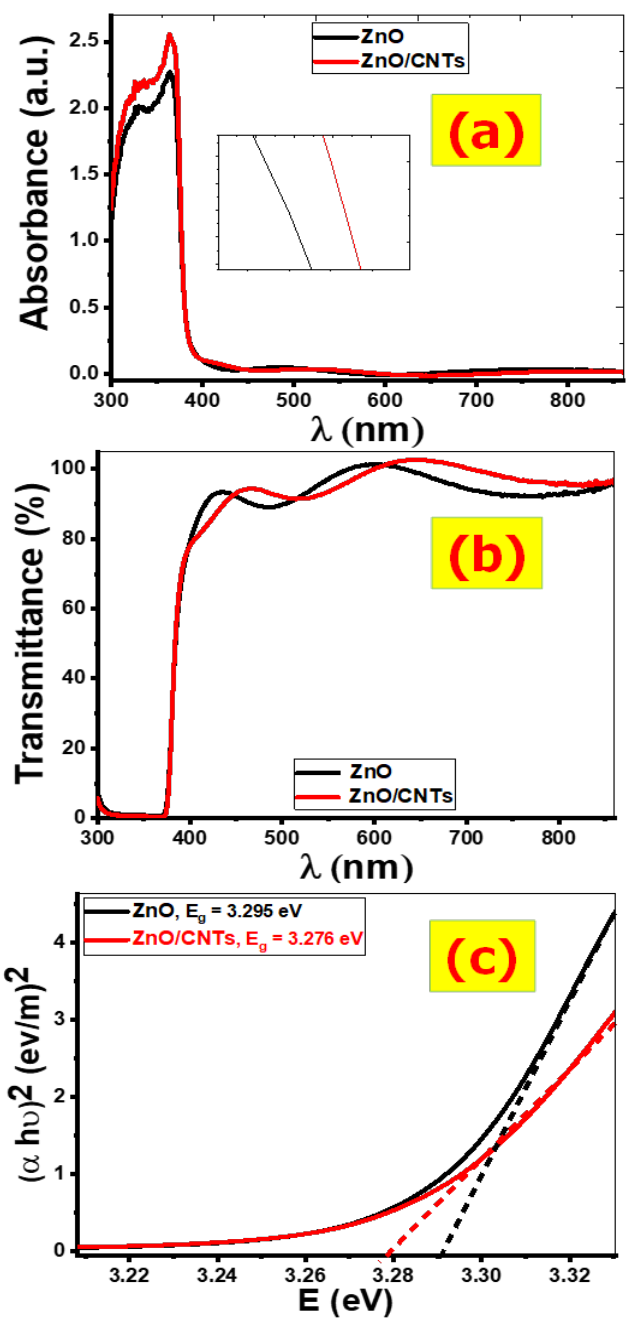
Figure 5. Optical spectra ( a ) absorption, ( b ) transmission, and ( c ) Tauc plots for ZnO and ZnO/CNTs thin films. thin